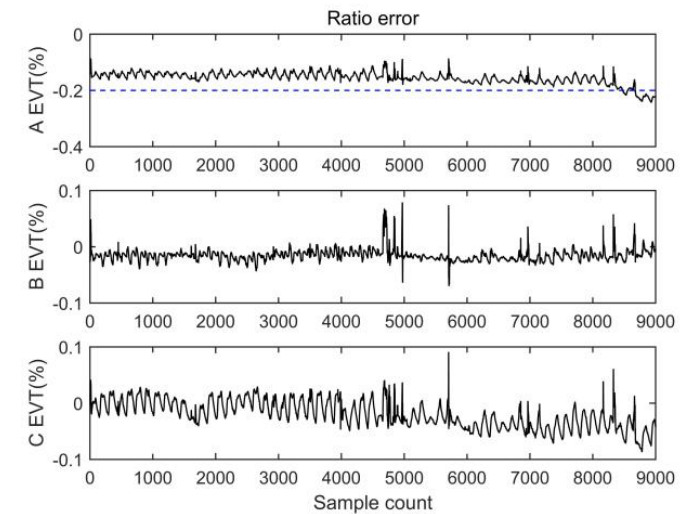
Figure 8. The ratio error of the EVT.